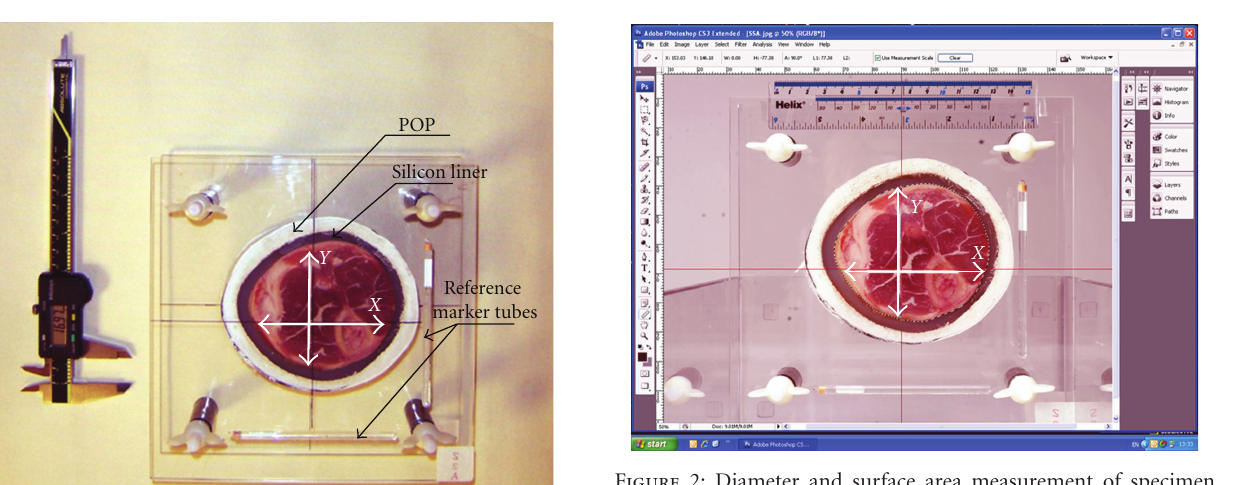
Figure 2: Diameter and surface area measurement of specimen using Adobe Photoshop Extended version.